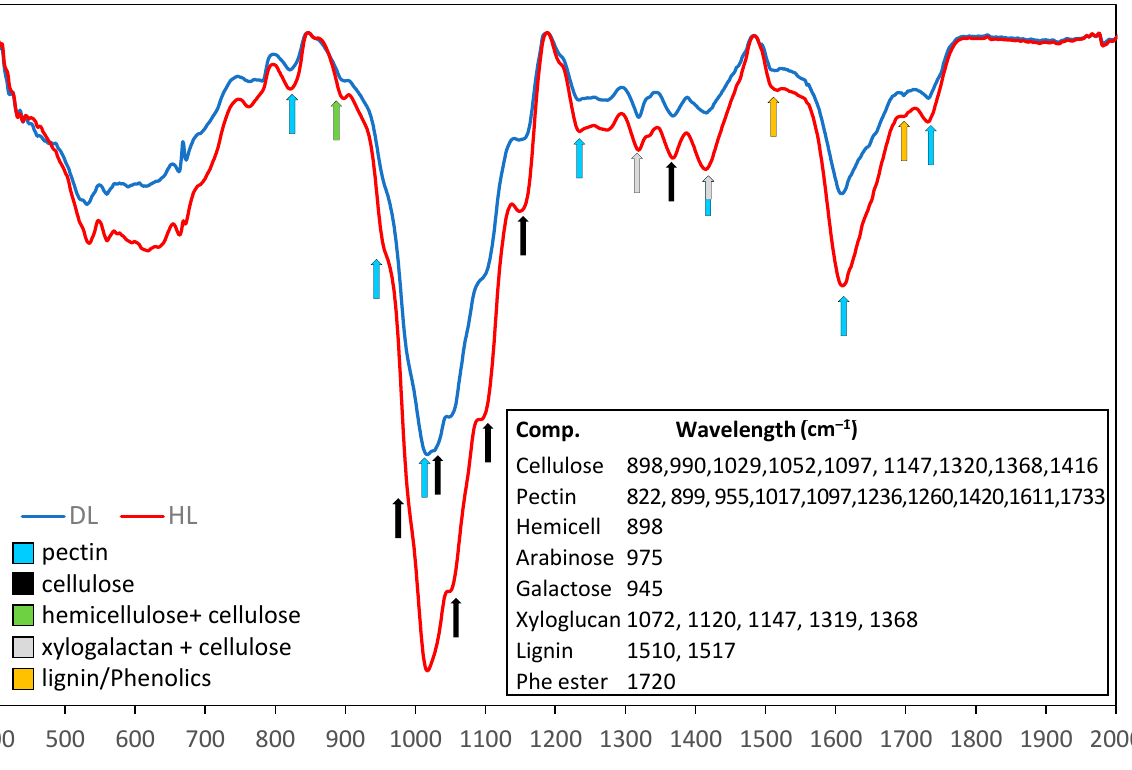
Figure 8. FTIR spectra of the cell walls of R. serbica HL (red line) and DL (blue line). The average spectra of seven HL and seven DL samples (biological replicates) are shown. Peaks corresponding to cellulose, pectin, hemicellulose, xylogalactan, and lignin (phenolic ring and phenolic esters) are pointed.